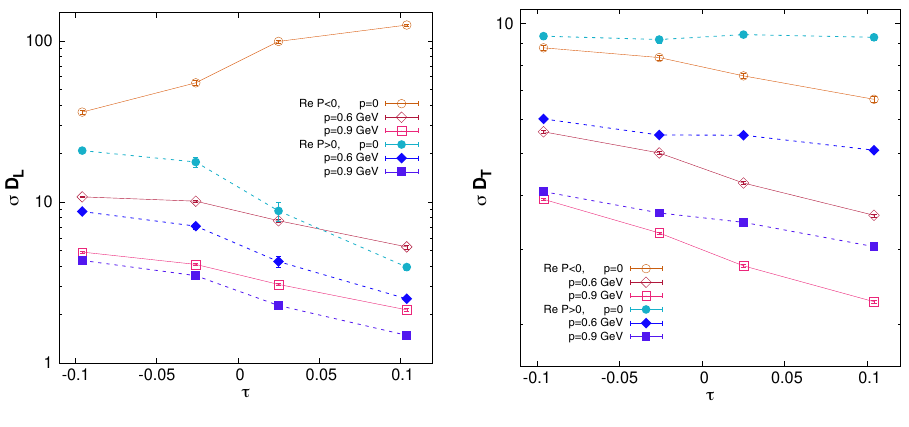
Figure 5: Fraction of variance unexplained: the dependence on lattice size is shown in the SU(2) case (left panel), the dependence on the temperature – for the SU(3) case (right panel) both for and D A Figure 6: Temperature dependence of the longitudinal (left panel) and transverse (right panel) gluon propagators at various values of momenta in the SU(3) case. Lines are shown just to guide the eye, also notice the logarithmic scale on the ordinate